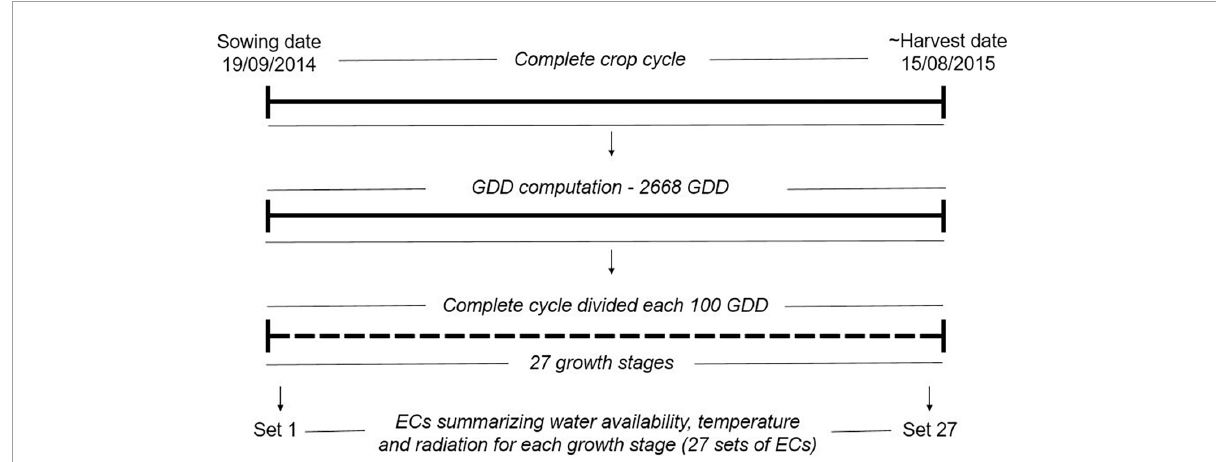
FIGURE1 Computation of growth stages and environmental covariates (ECs) for year 2014 in the locality of Skive. In total, the complete crop cycle was divided into 27 shorter periods of 100 GDD (27 growth stages). For each growth stage, a set of ECs summarizing environmental descriptors linked to water availability, radiation and temperature were computed as described in Supplementary material 1 . The same approach was used for all year-location combinations. GDD: growth degree days, the GDD were estimated as the thermal sum of daily average temperature over 0 ◦